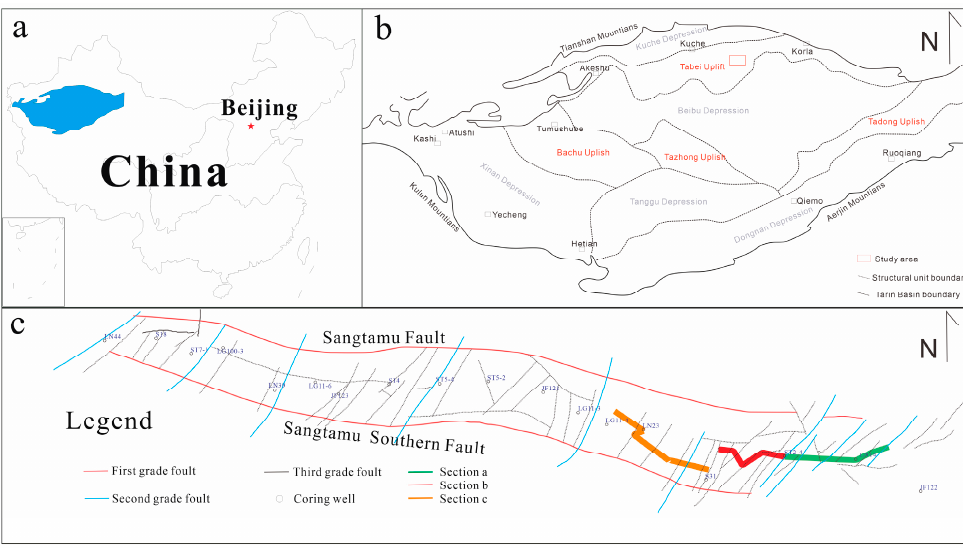
Figure 1. Geographic location distribution of the Sangtamu oilfield. ( a ) Geographical location of Tarim Basin; ( b ) Structural Map of Tarim Basin; ( c ) Wells location of Sangtamu oilfield. The Triassic system is divided into the TI, TII, and TIII oil groups [32–34]. A thick